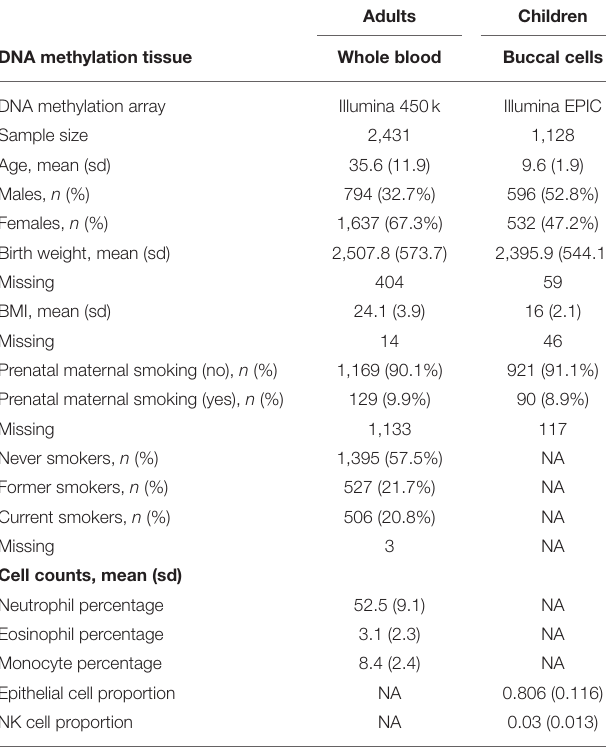
TABLE 2 | Characteristics: NTR adults and